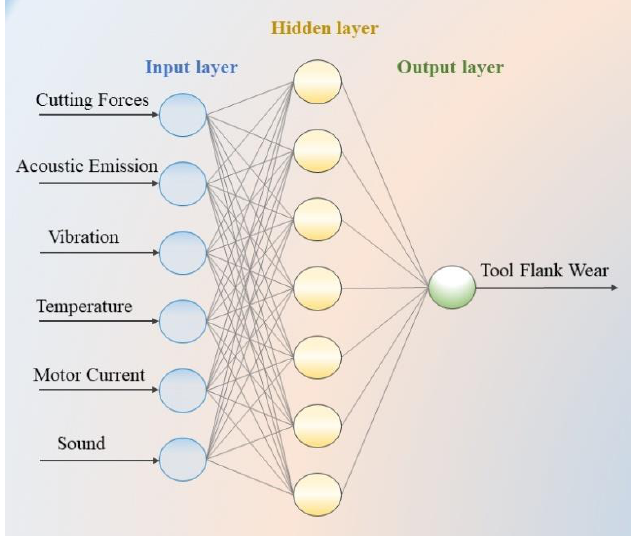
Figure 12. The structure of artificial neural network model.